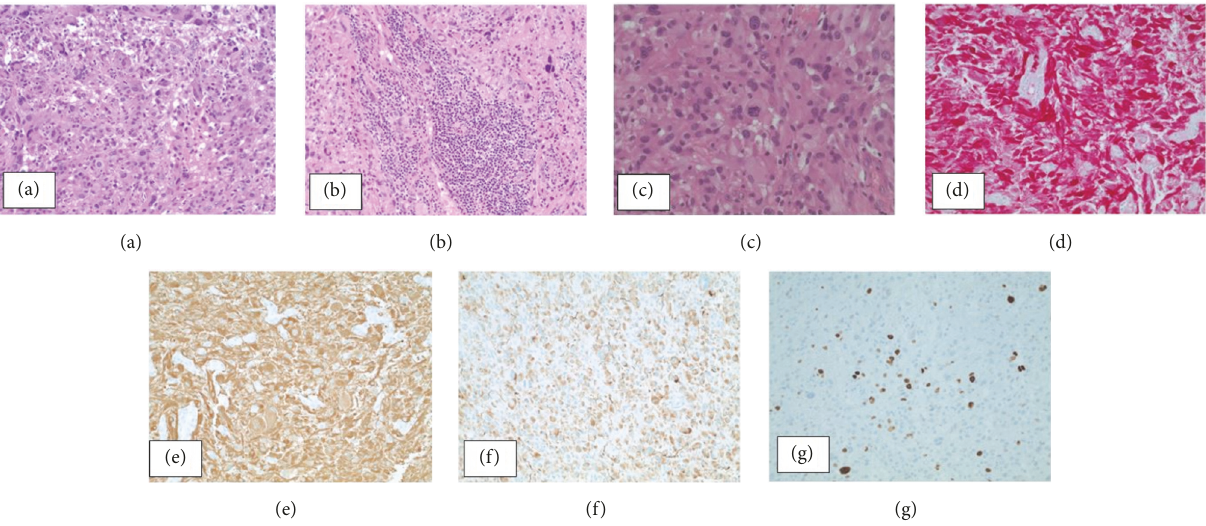
Figure 2: (a) Histologic sections showing a cellular proliferation of pleomorphic cells, some of which are multinucleated (H&E stain, 100x original magnification); lymphocytic infiltration is also seen (b); (c) neoplastic cells show eosinophilic cytoplasm and intracytoplasmic vacuoles, with mitotic figures identified (H&E stain, 400x original magnification); immunohistochemistry shows diffuse reactivity for S-100 (d), GFAP (e), and neurofilament (f); the Ki-67 proliferative index is moderately elevated